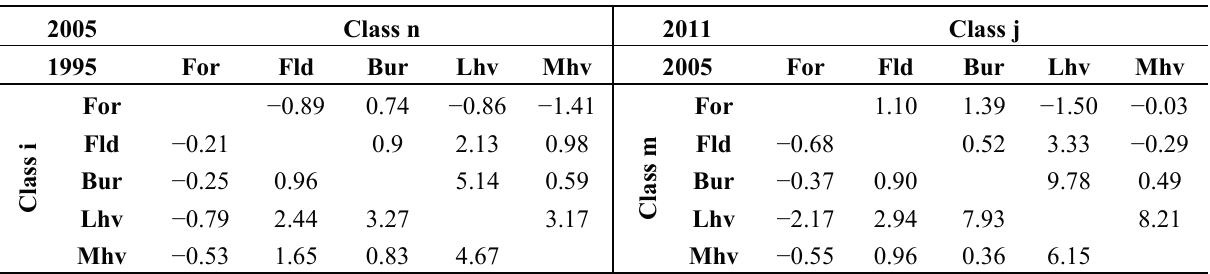
Table 8. Transition matrix for two intervals, 1995–2005 ( left ) and 2005–2011 ( right ), showing added differences between observed and uniform intensity for gain (Table 6) and loss (Table 7).